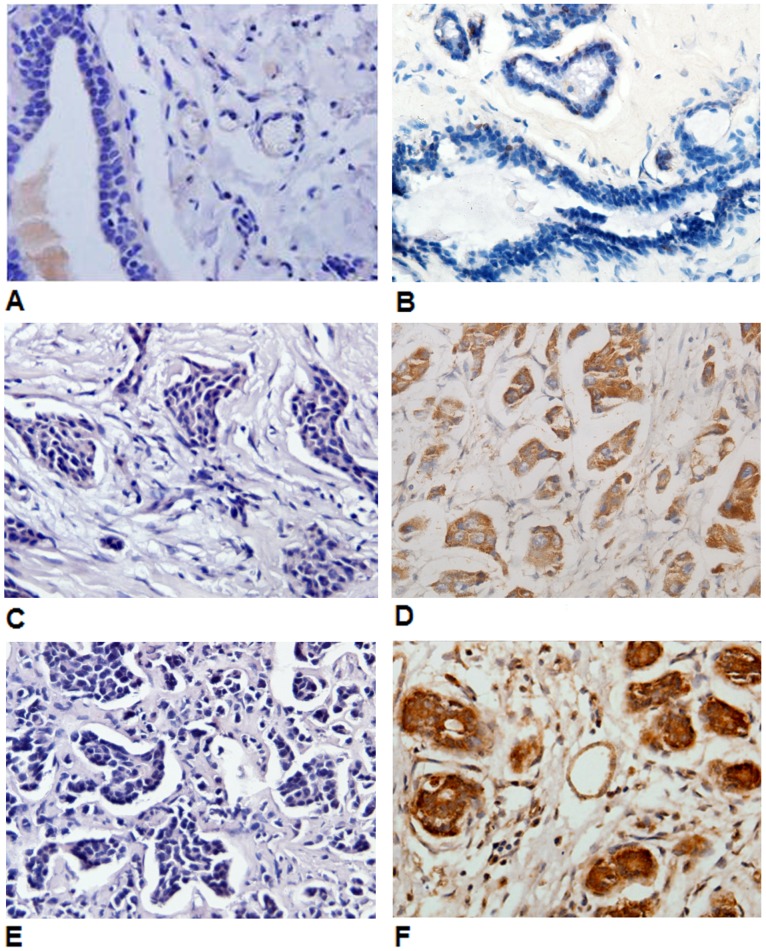
Periostin was located in the cytoplasm and membrane of the breast cancers.It was observed that Periostin was either not expressed or expressed low in paracancerous tissues (A, x400) and atypical hyperplasia tissues (B, x400); expressed low in cases without lymph node metastasis (C, x400) and expressed high in cases with lymph node metastasis (D, x400); expressed low in the non-triple-negative breast cancers (E, x400) and expressed high in triple-negative breast cancers (F, x400).